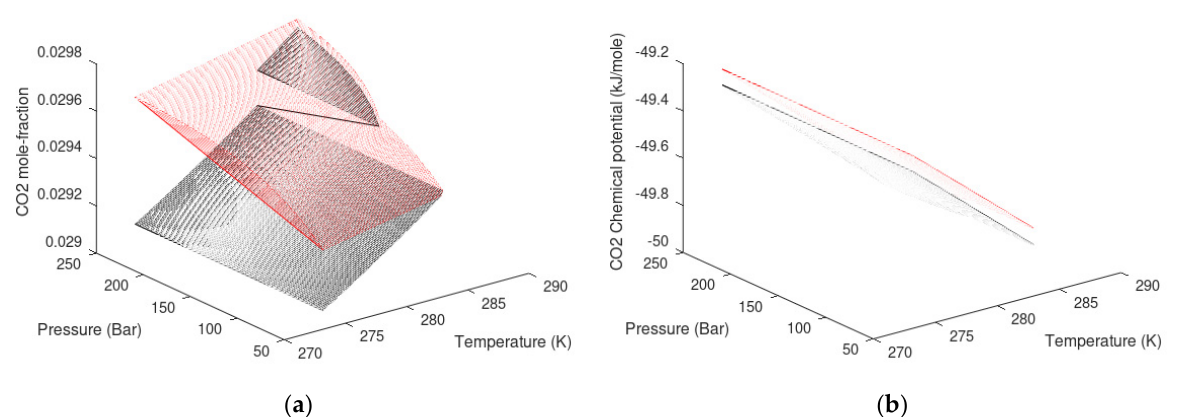
Figure 13. ( a ) Minimum mole ‐ fraction of CO 2 in surrounding water needed to keep CO 2 hydrate stable (black). Solubility of CO 2 in water (red). ( b ) Chemical potential for water corresponding to mole ‐ fractions CO 2 in water for minimum mole ‐ fractions CO 2 in surrounding water needed to keep hydrate stable (black) and chemical potentials for water in CO 2 solubility mole ‐ fractions (red).